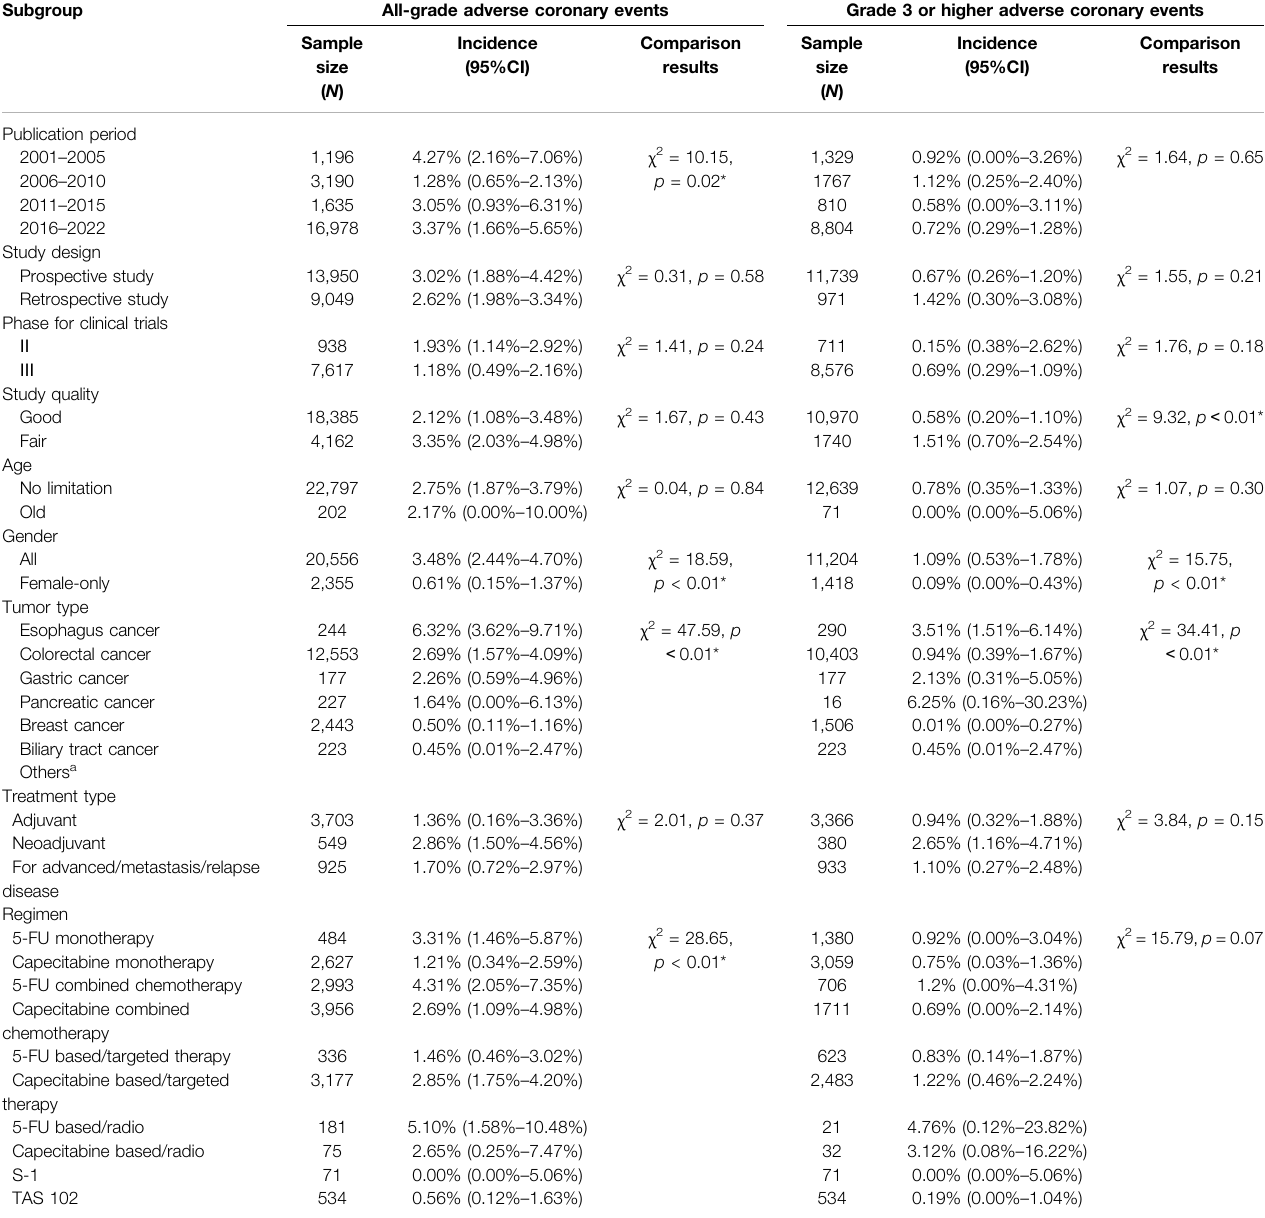
TABLE 2 | The pooled incidence of coronary disorder in each subgroup and the comparison results.